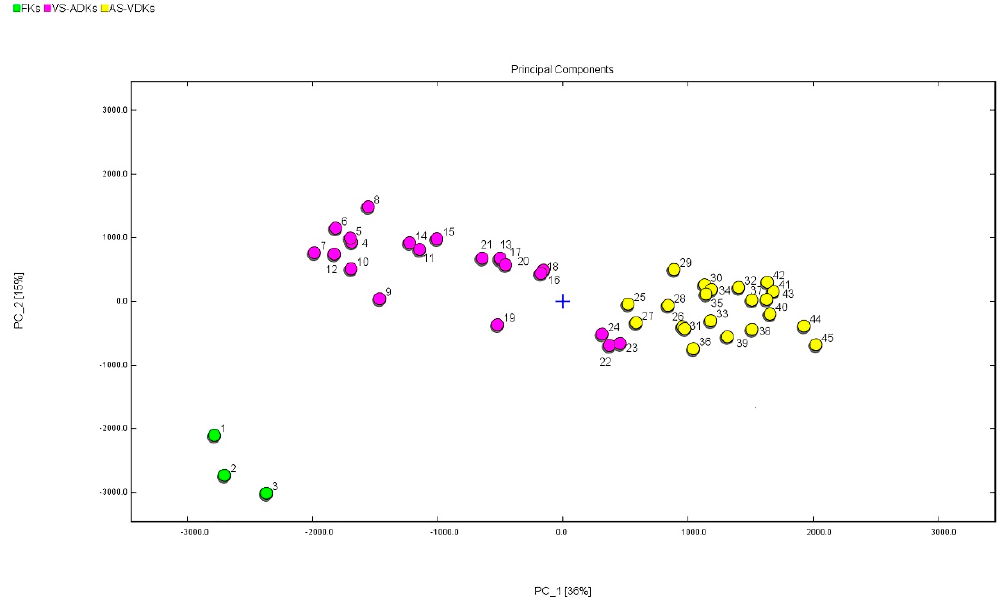
Figure 7. PCA based on the signal intensity obtained with different treatment processes of FKs, VS-ADKs, and AS-ADKs.